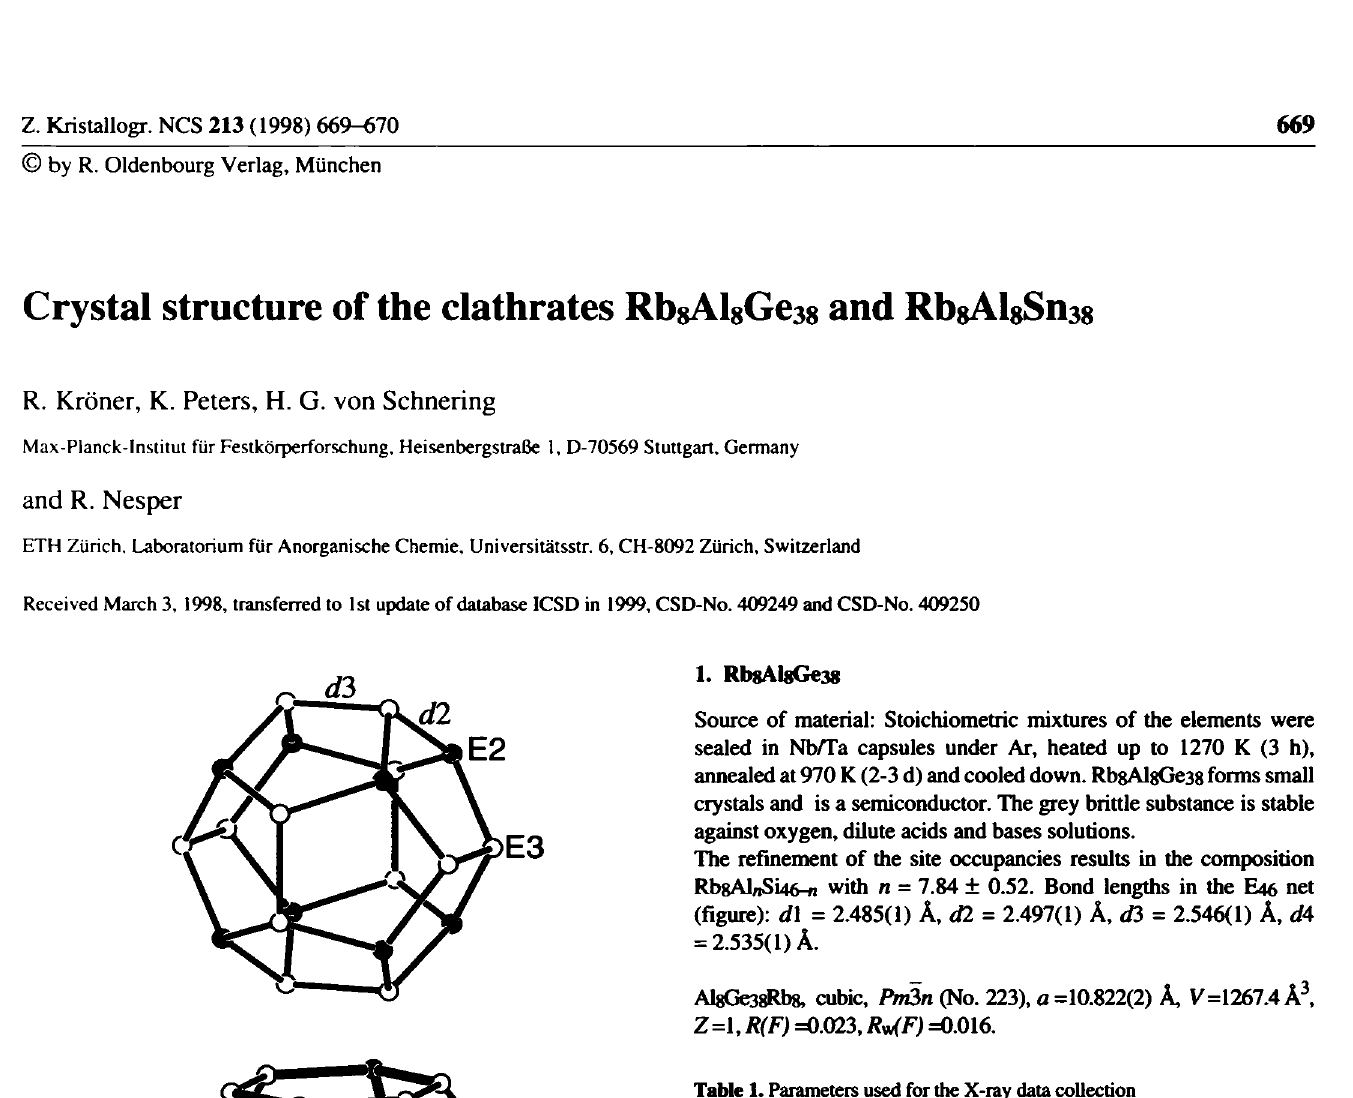
Table 1. Parameters used for the X-ray data coUection Crystal: